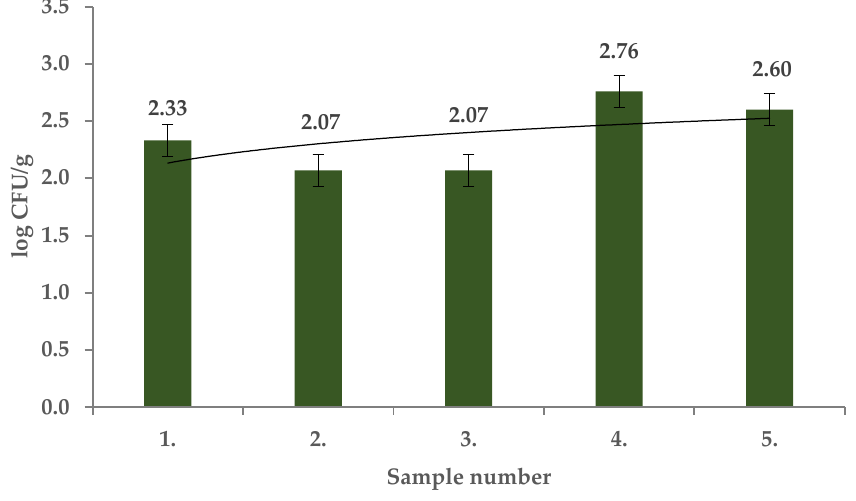
Figure 5. Yeasts counts in fruits of Rosa canina.